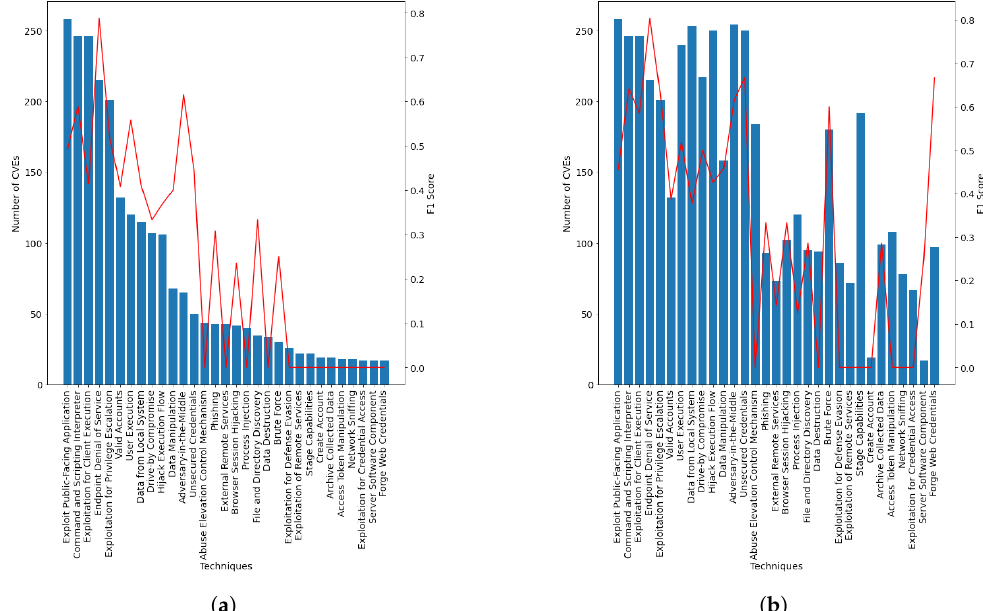
Figure 9. Comparing the F1-score over the CVE distribution for the SciBERT model. ( a ) Without aug- mentation; ( b ) With augmentation. Table 3. Precision, Recall and F1-Scores for the best